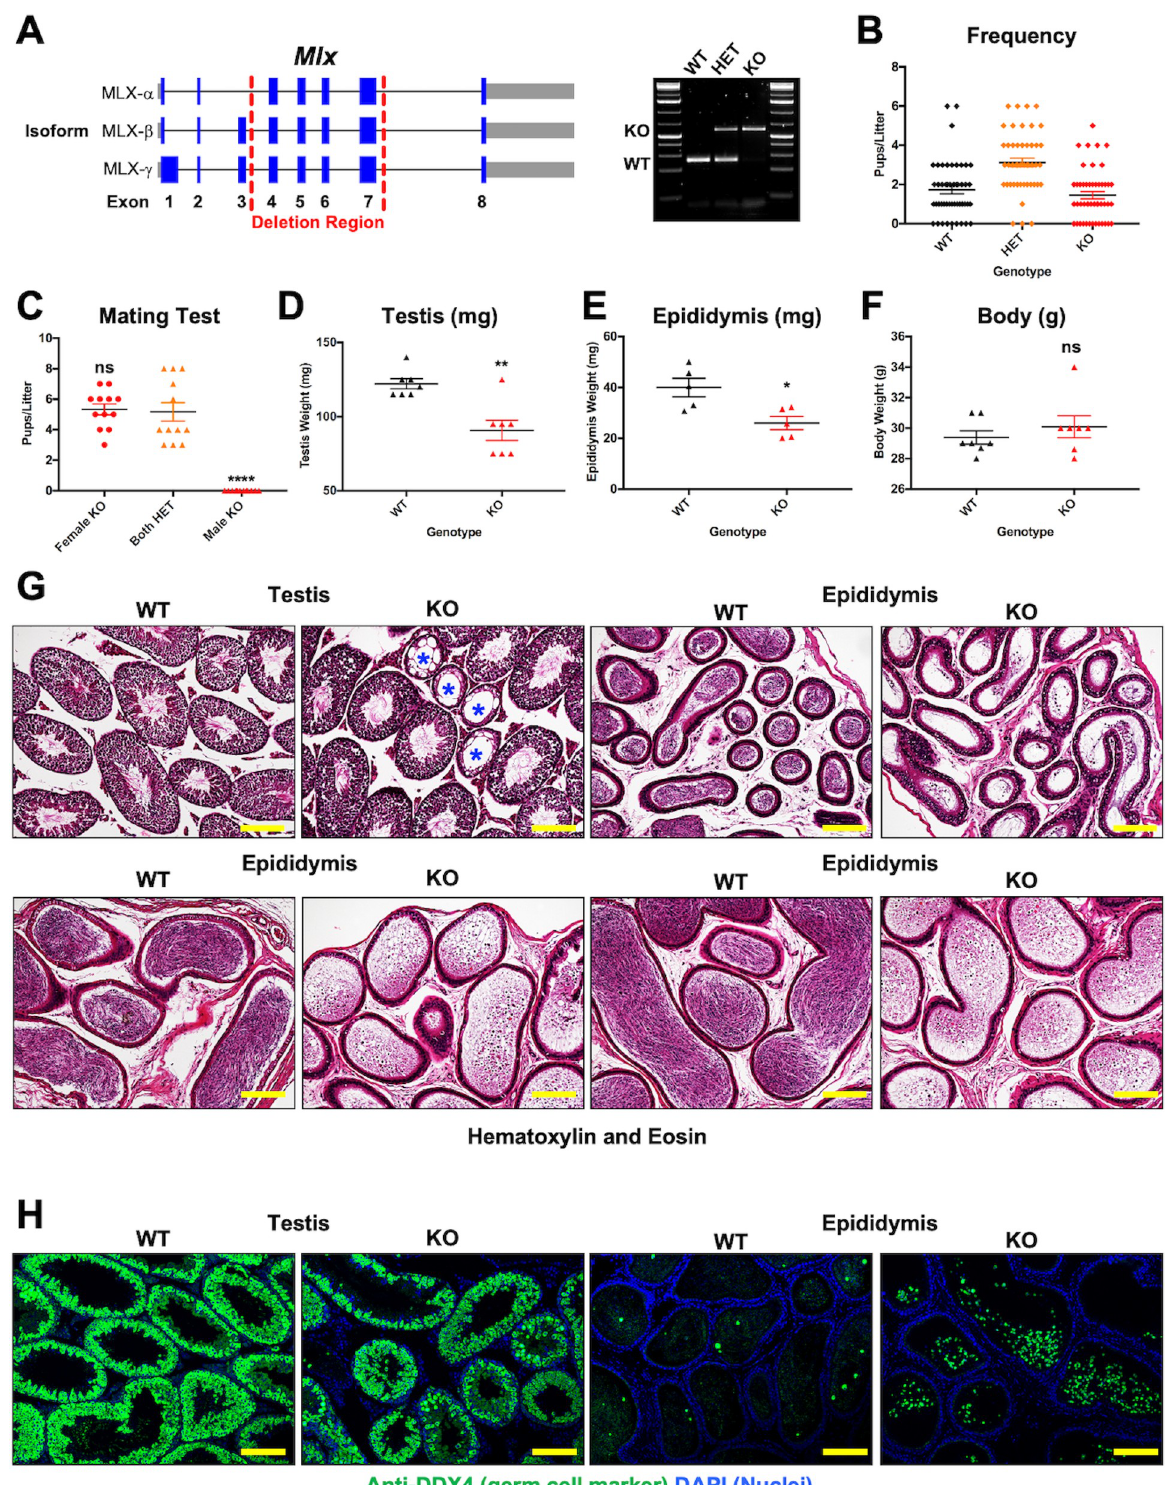
Fig 1. Targeting strategy and initial reproductive characterization of the MLX KO mice. ( A ) Cloning strategy for deletion of exons 3 to 6, encoding the DNA-binding domain, of murine Mlx- α with PCR products of the 3 potential genotypes WT, HET, and KO shown to the right. ( B ) Pups/litter from mating tests between MLX HET males and females ( N = 48). ( C ) Mating test results from crossing the indicated sex and